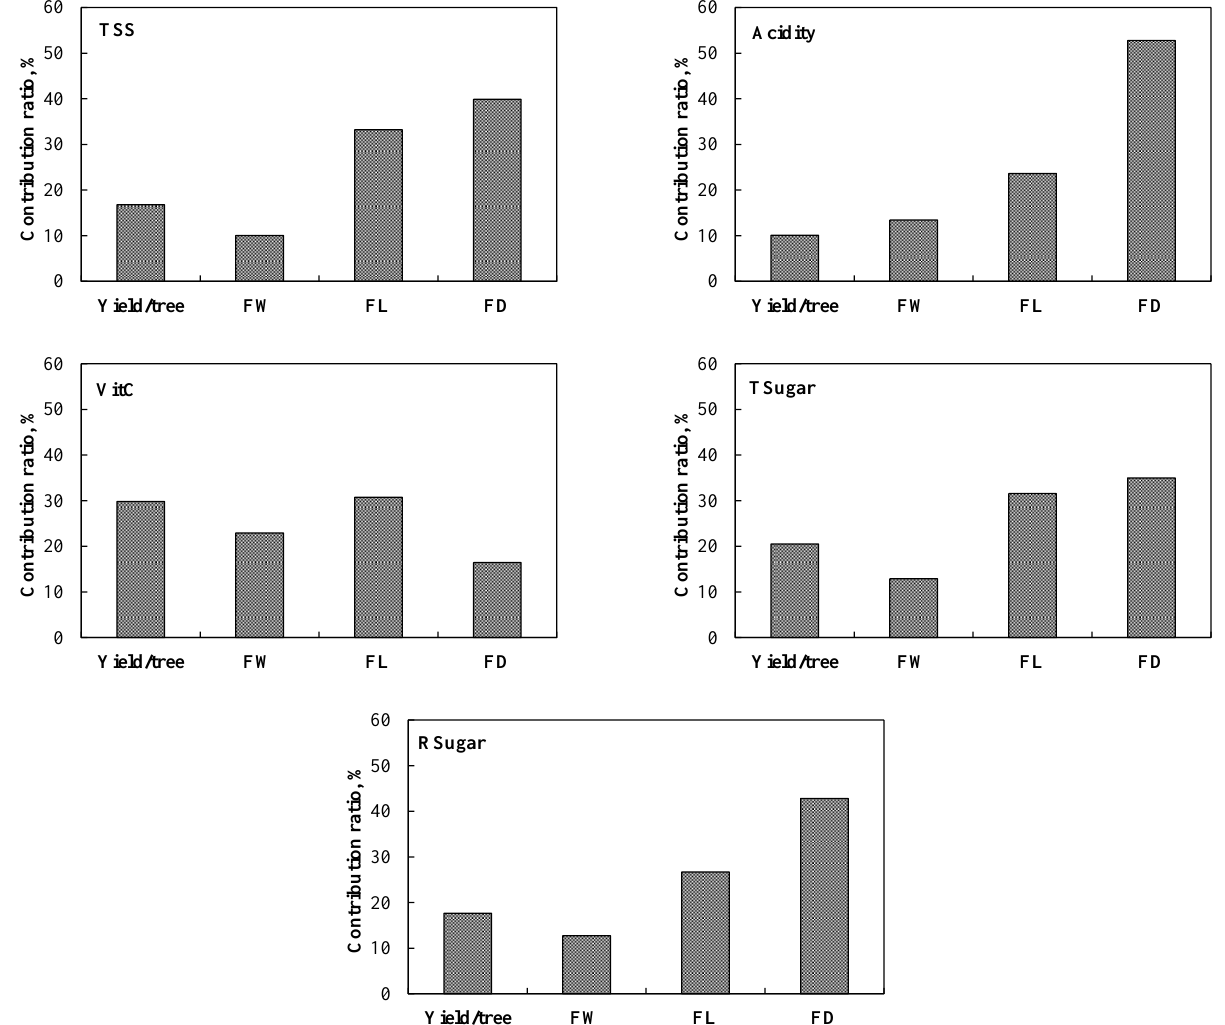
Figure 7. Contribution ratio of the input variables in the ANN model. FW, fruit weight; FL, fruit length; FD, fruit diameter; TSS, total soluble solids; VitC, vitamin C; Tsugar, total sugars; Rsugar, reducing sugars.